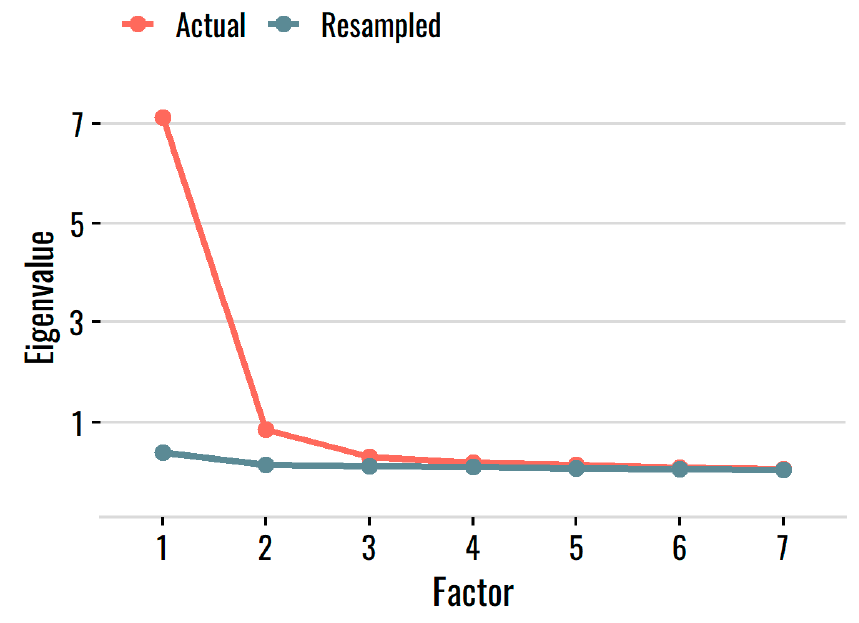
Figure 1. Actual and resampled eigenvalues from the parallel analysis. Note: Only the first 7 factors are shown for